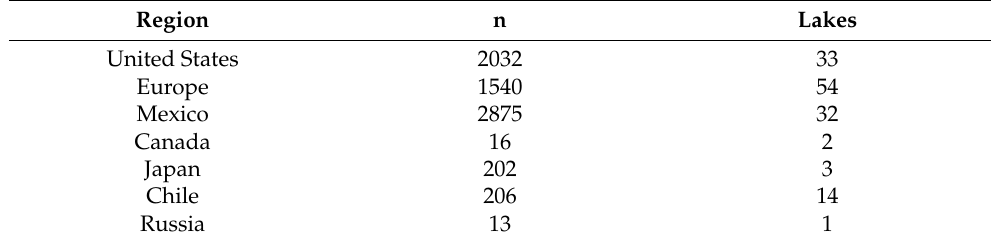
Table 3. Overview of the number of observations and lakes per region in the cleaned dataset. Region n Lakes